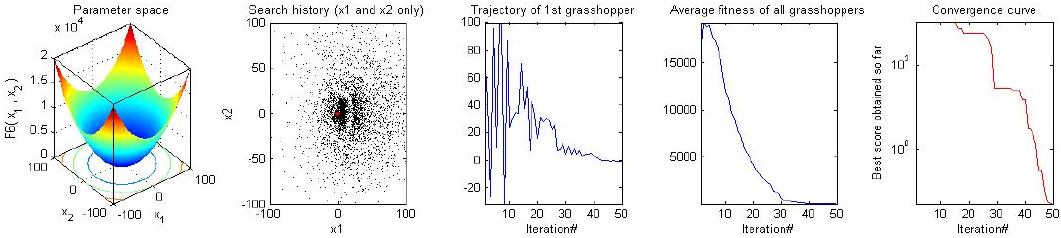
Figure 7. HAGOA search behavior on unimodal function (F6)